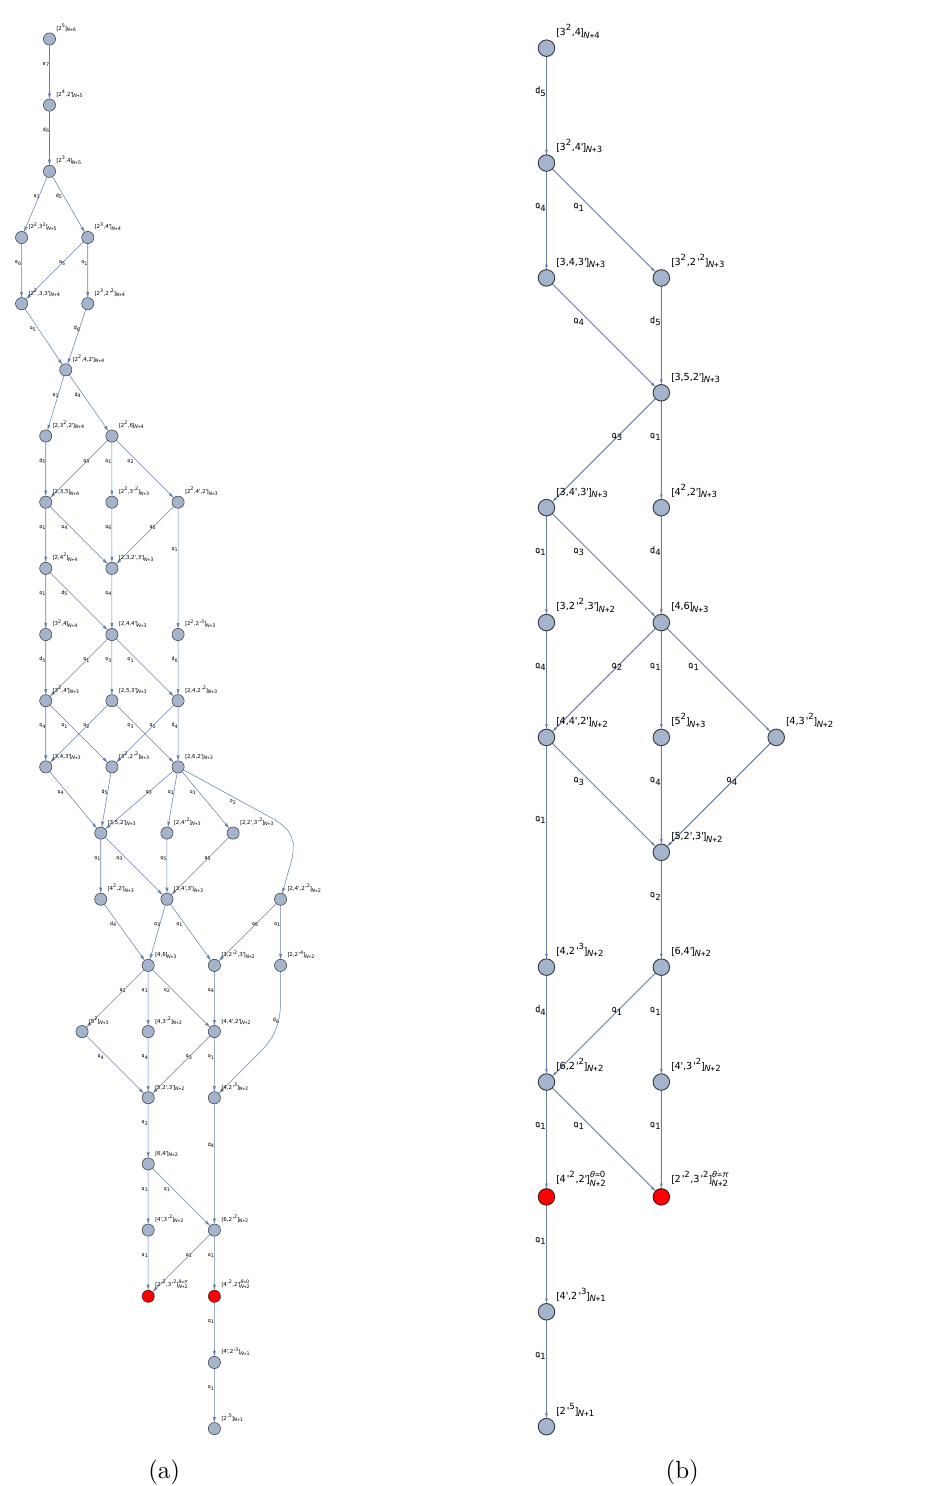
Figure 7. Hierarchy of RG flows for (a) massive E 7 -theories with n 0 = 2 and k = 12 , and (b) massive E -theories with n = 3 and k = 13 . The labels colored in red differ by a 6d θ angle along 6 0 the tensor